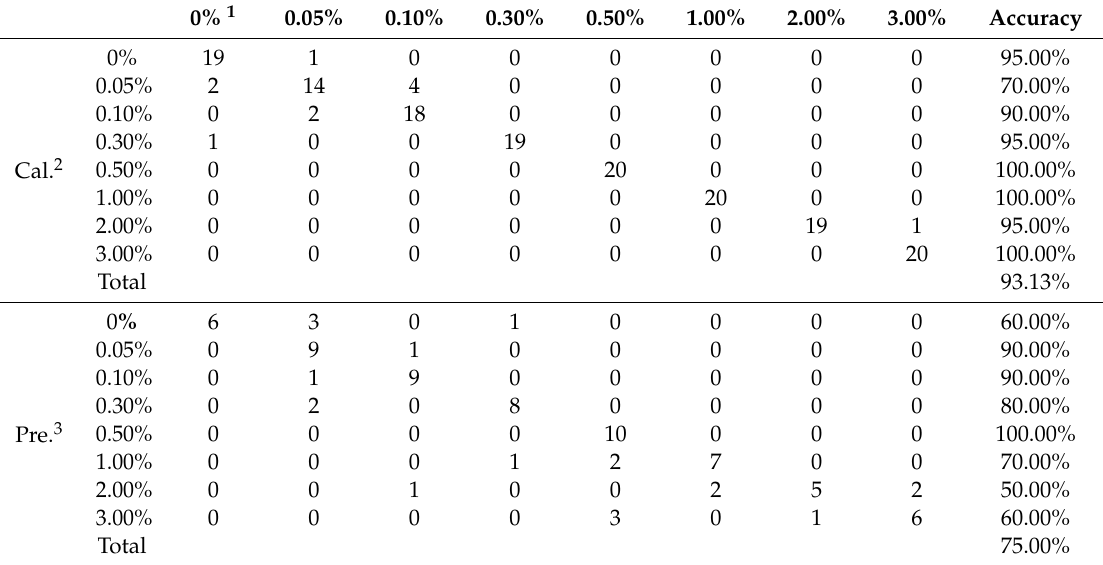
Table 4. Confusion matrix of SVM model based on the important wavelengths for classification the samples by the portable NIR spectrometers.